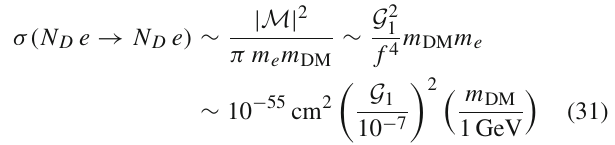
, and the Yukawa 11